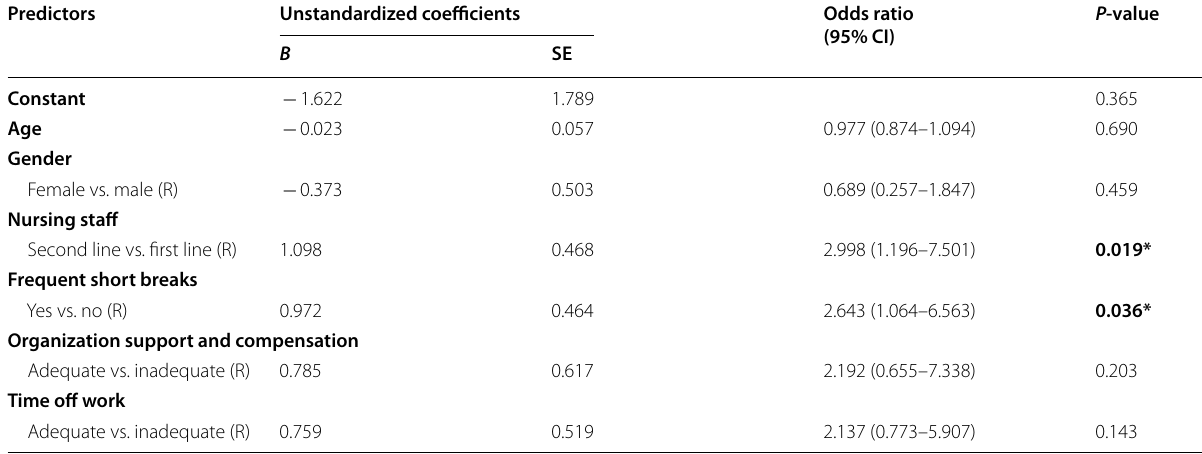
Statistical significance at P